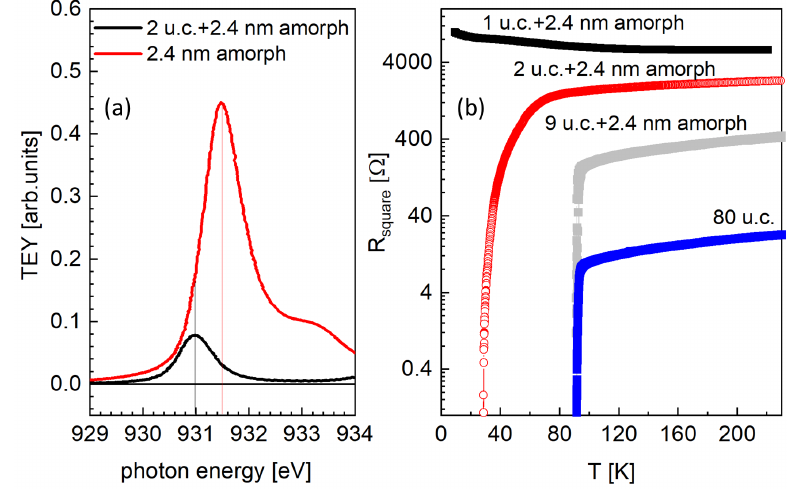
Figure 2. Panel ( a ) XAS measurements in total electron yield (TEY) mode of 2 u.c.-thick NdBa 2 Cu 3 O 7 − x film covered with a 2.4 nm-thick amorphous layer of the same material (red line) and of the 2.4 nm-thick amorphous layer alone (black line). Panel ( b ) Resistivity measurements of 1 u.c. (black symbols), 2 u.c. (red symbols), 9 u.c. (gray symbols) -thick NdBa 2 Cu 3 O 7 − x films covered with a 2.4 nm-thick amorphous layer of the same material and of 80 u.c.-thick NdBa 2 Cu 3 O 7 − x film (blue symbols) with no capping